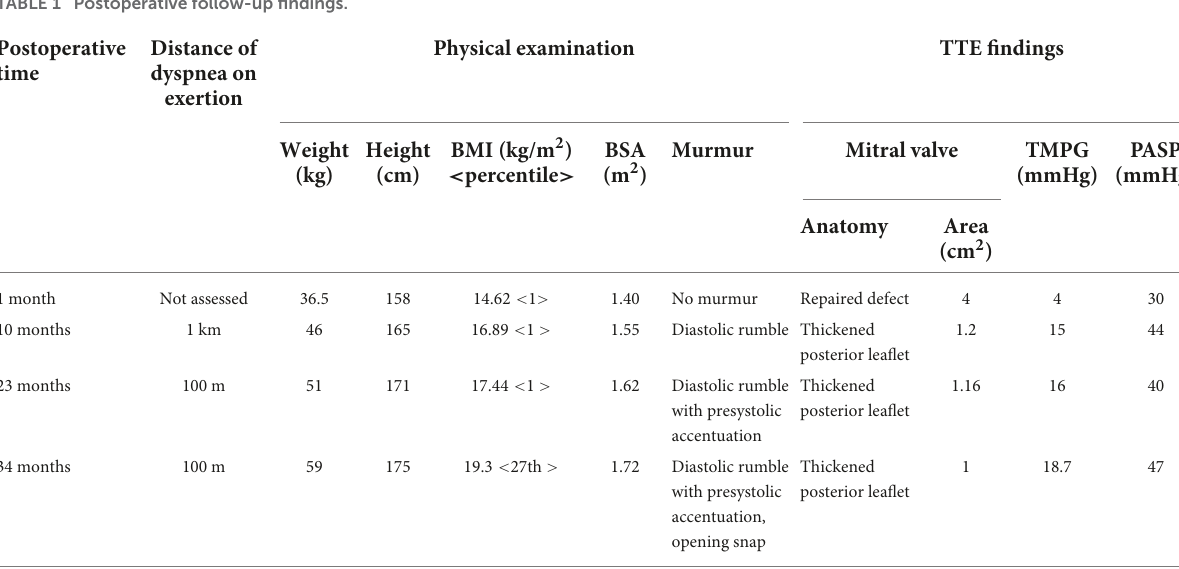
TABLE 1 Postoperative follow-up